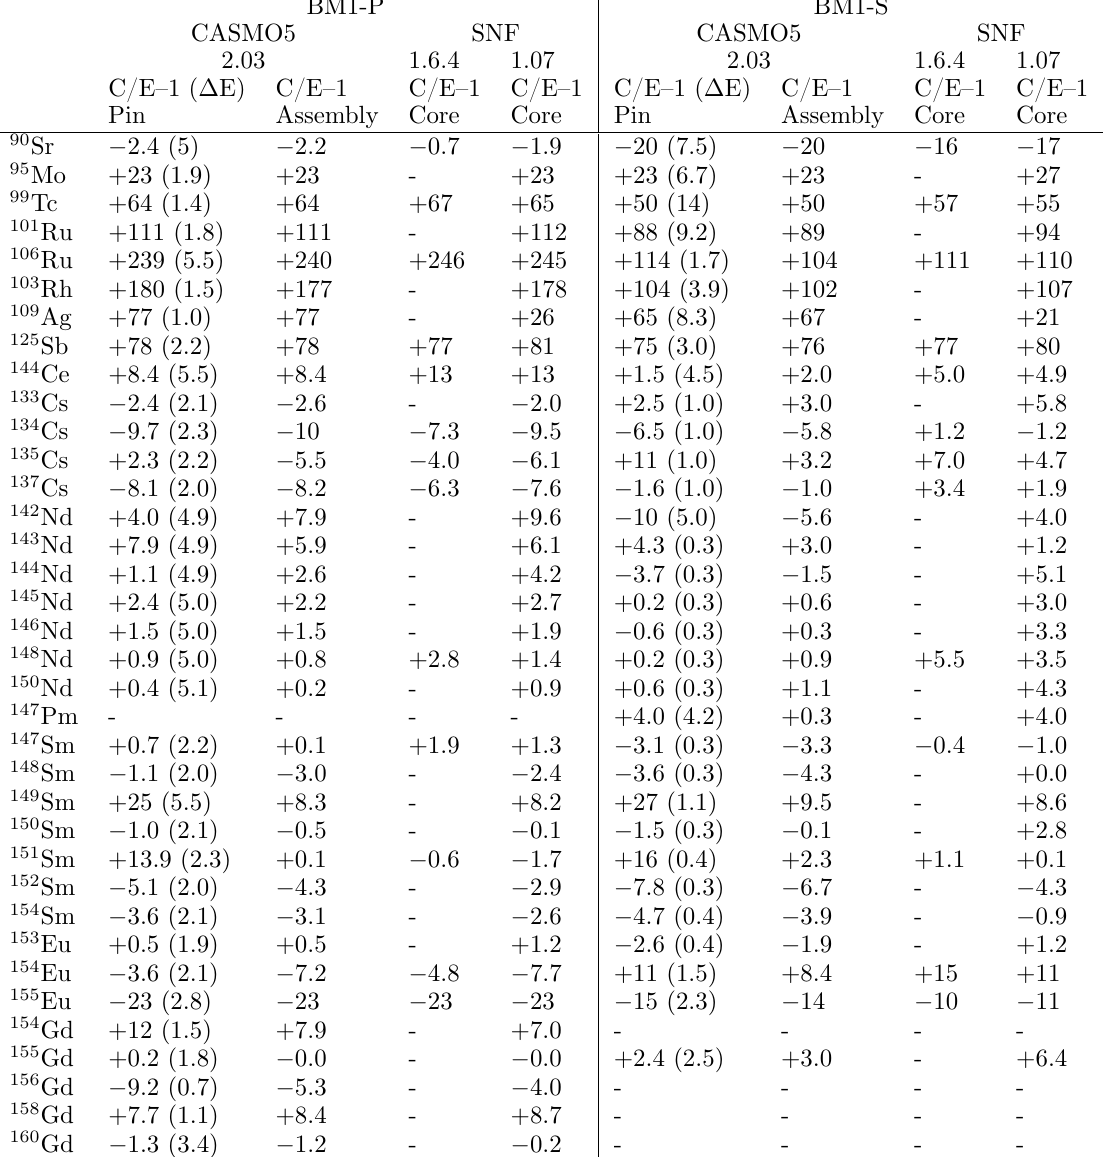
Table B.4. Nominal C/E–1 values and experimental uncertainties for fission products in % (1 σ ) for the BM1-P and BM1-S